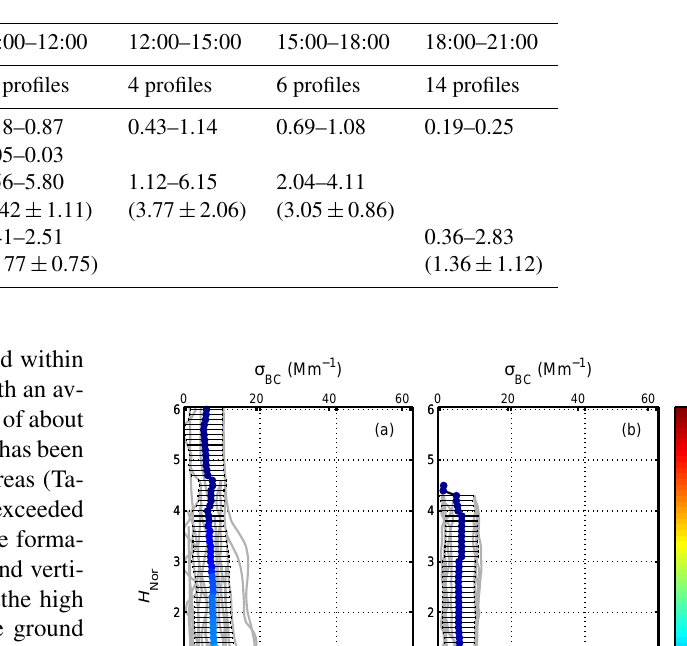
Table 2. Statistical parameters for BC vertical profiles measured during different periods. Notations for the parameters have been given in the text.